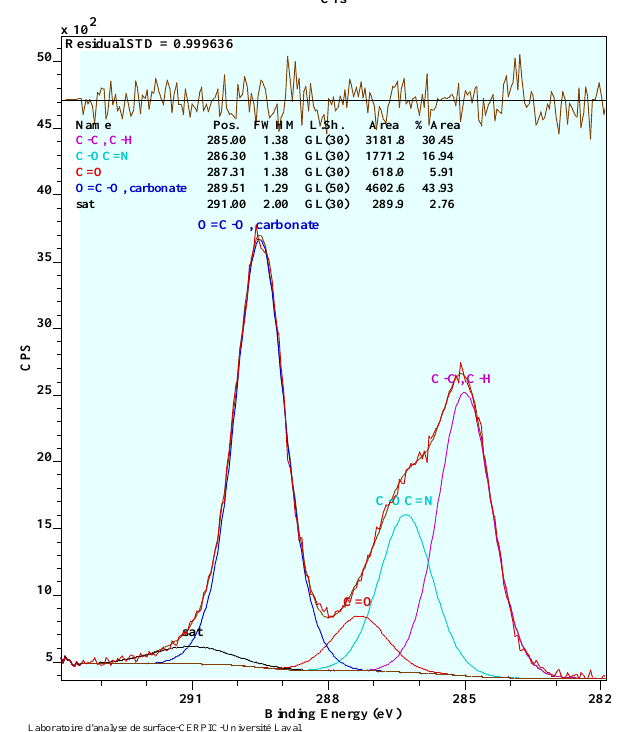
Figure 7. C 1 s high resolution spectra on embedded UVAs into CaCO 3 sample.